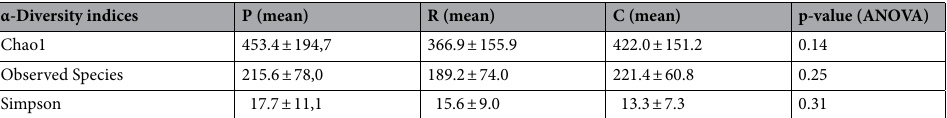
Table 2. OTU-based diversity indexes in fecal samples of the experimental groups of subjects. The table shows the total number of OTUs, (b) Chao index and (c) Simpson’s evenness indexes in CFS patients, patients’ relatives and external control group respectively. Univariate (ANOVA) test is applied in order to assess significant differences between groups (p < 0.05). P CFS/ME patients, R patients’ relatives, C external control